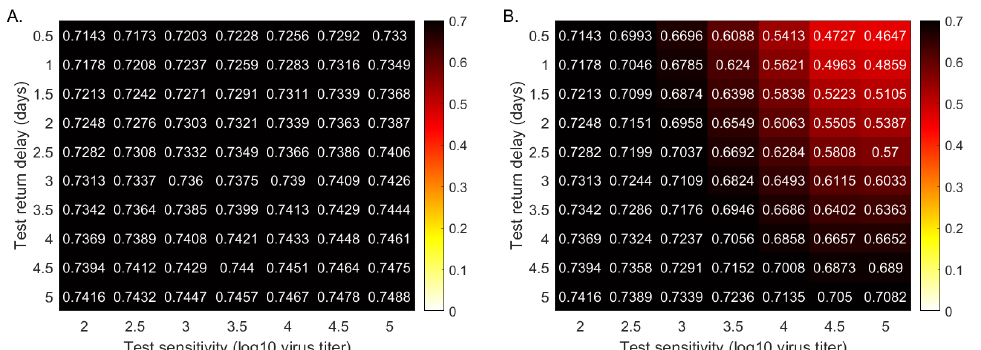
Figure A1. Cumulative positive cases (as proportion of the total population) at half a year. RT-PCR with return delay (cid:96) = 1 days (dark blue), (cid:96) = 2 days (light blue) and testing capacity C = 0.1; Ag test with return delay (cid:96) = 0.5 days and testing capacity C = 1 (red), C = 0.5 (orange), C = 0.33 (maroon), and C = 0.1429 (magenta). All other parameters and initial conditions are given in Tables 1 and 2.